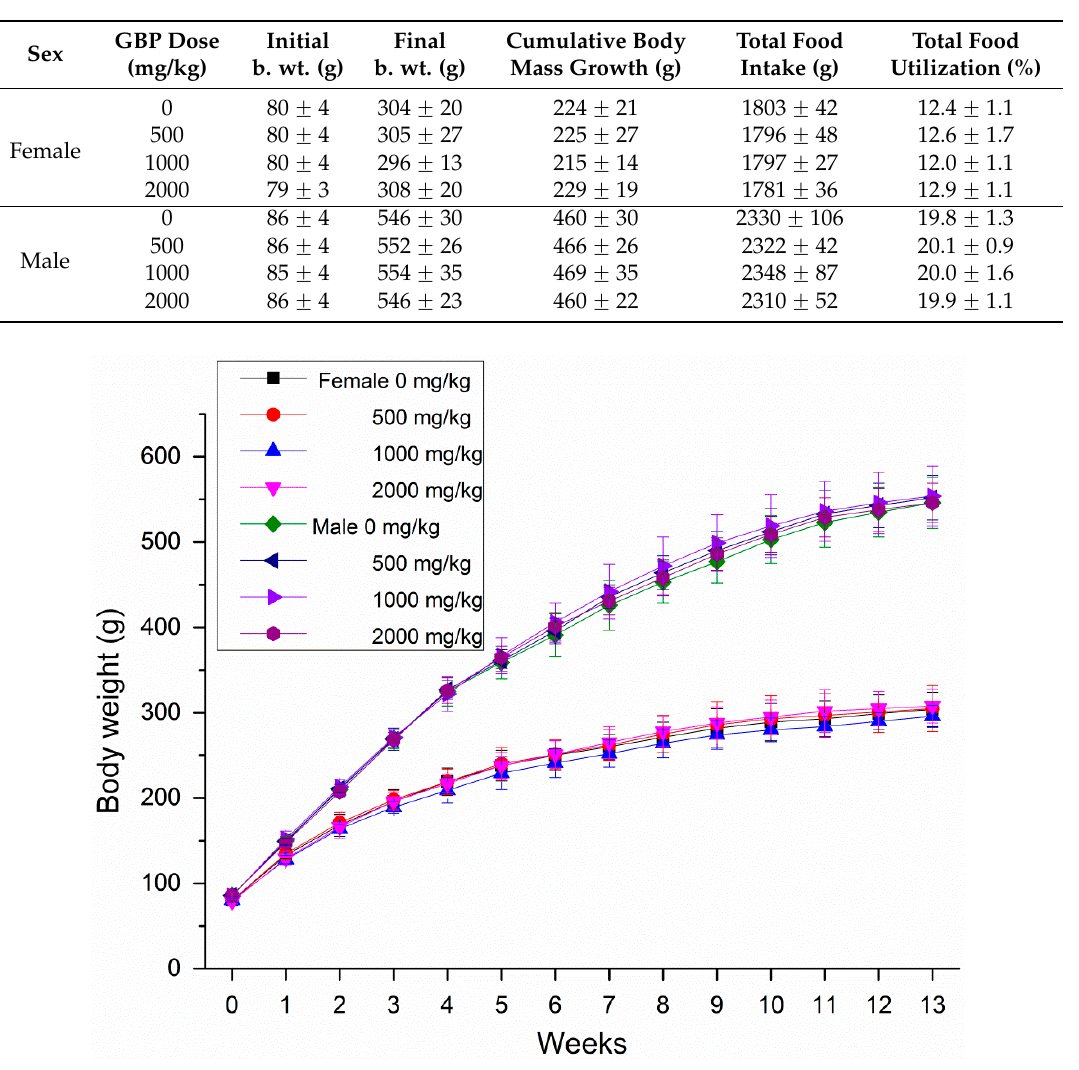
Figure 3. Body weight of female and male rats treated with GBP per week for 91 days.